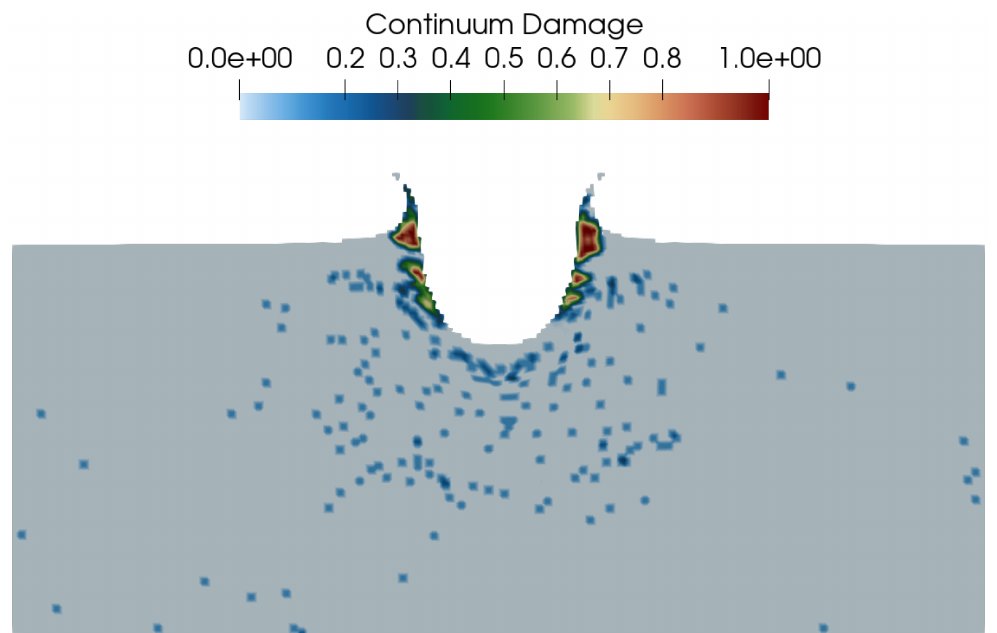
Figure A2. FLAG simulation of 5 × 10 3 m/s Al-Al (Al-6061) normal impact, 3 s after impact, colored by